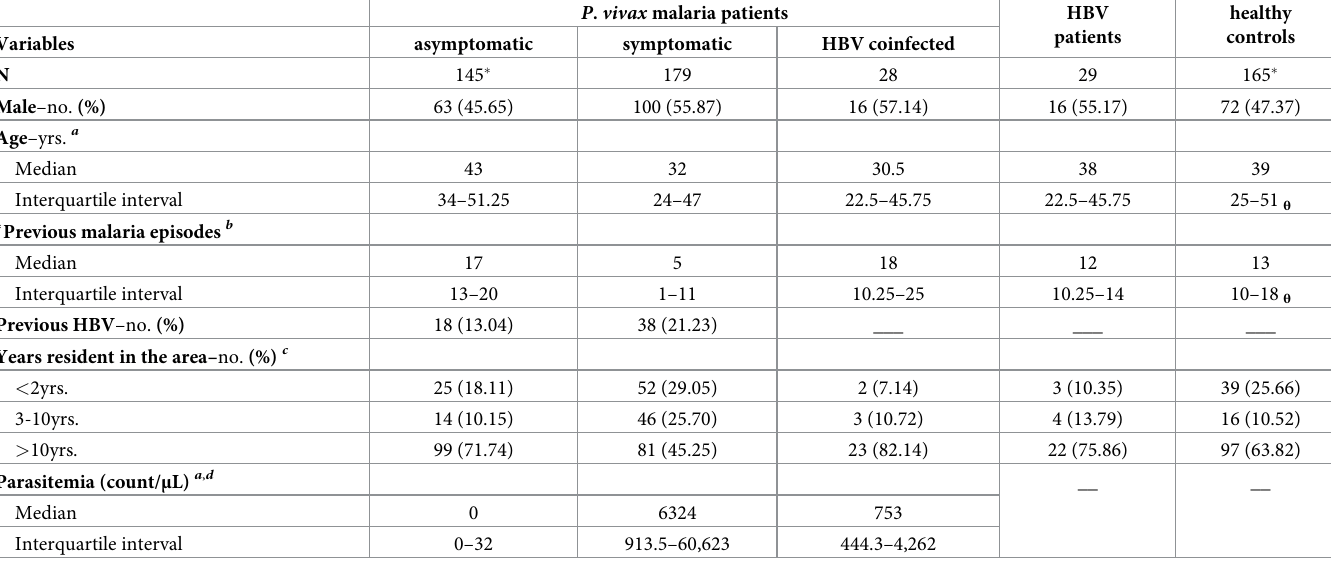
Table 1. Characteristics of the study